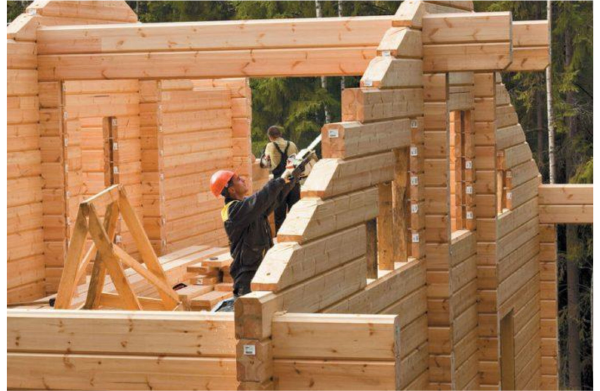
Figure 3. Log construction system